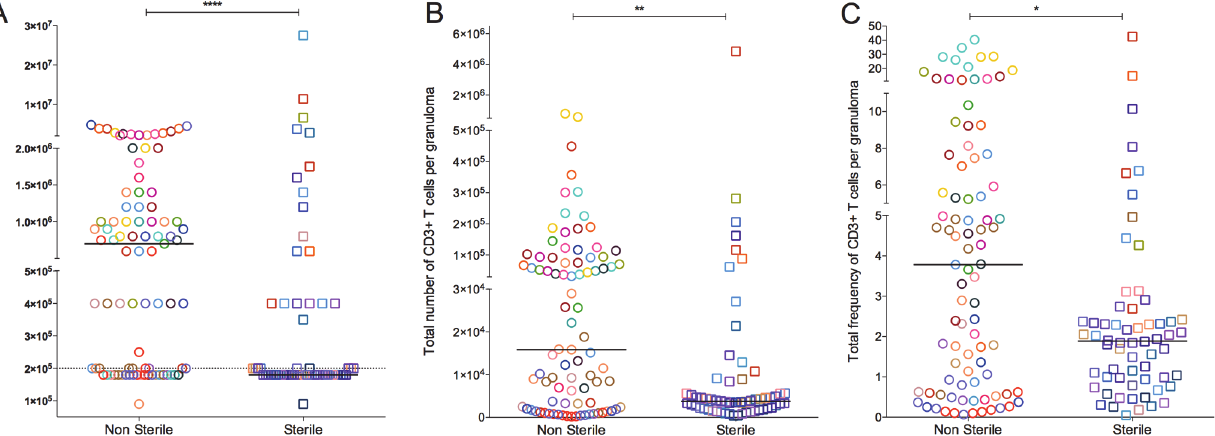
Figure 2. Absolute cell counts per granuloma. A: Total number of cells obtained from granuloma. Granulomas with a cell count less than the detection limit was assigned 9×10 4 before the correcting for the dilution factor. B : Total number of T cell counts, defined by CD3+ per granuloma. C is the total percentage of live CD3+ cell per granulomas and was used to extrapolate the absolute T cell count per granuloma (B) from the total granuloma cell count (A). Each symbol represents a granuloma. Each color represents an animal. Granulomas are grouped based on bacterial burden of the granuloma: non-sterile (Mtb cultured, in open circles) or sterile (in open squares). Solid line indicates median in each group. Dotted line indicates the detection limit (1×10 5 ) before correcting for the dilution factor. ( **** : p < 0.0001, ** : p (cid:1) 0.001, Non-parametric Mann-Whitney).